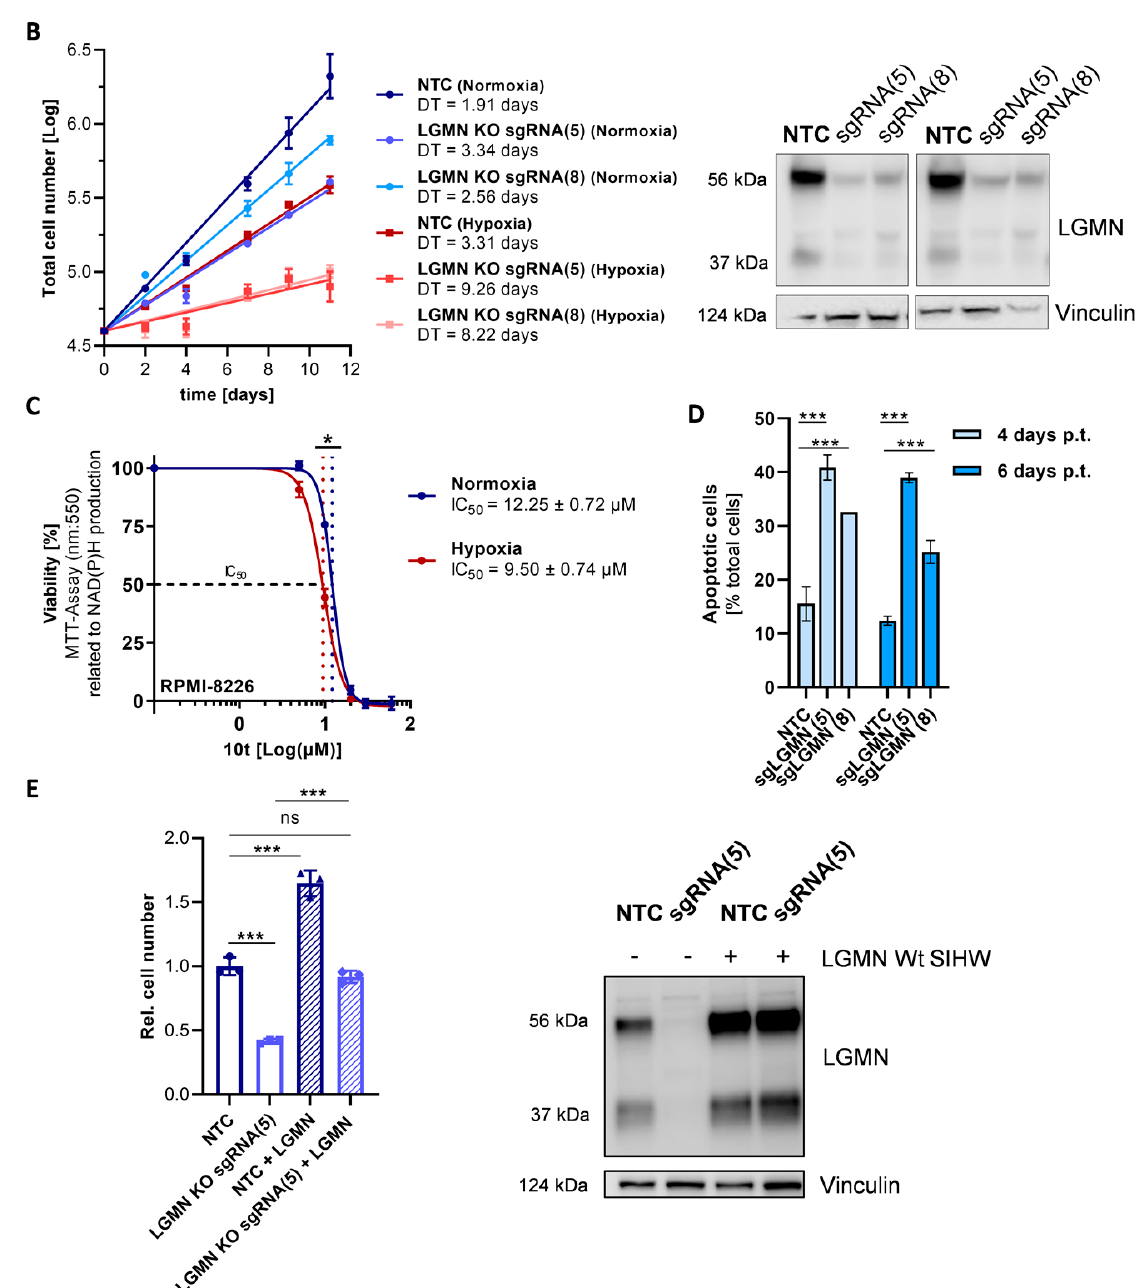
Figure 7. CRISPR/Cas9-based depletion of LGMN in MM cells confers enhanced growth disadvan- tage under chronic hypoxia: ( A ) Left: Competition growth assay of RPMI-8226 LGMN KO cells (sgRNA1, 3, 4 and 1 + 4) using NTC as a negative control and c-myc KO as a positive control in hypoxia (1% O 2 ). The percentage of GFP-positive cells measured via flow cytometry is normalized to NTC and day 0. Error bars indicate mean ± SEM of three technical replicates. Right: Representative Western blot of LGMN KO in RPMI-8226 cells used in the competition assay. Loading control: Nu- cleolin. ( B ) Left: Cumulative growth assay of RPMI-8226 LGMN KO (sgRNA5, 8) and NTC cells in normoxia (21% O 2 , blue colors) and hypoxia (1% O 2 , red colors). Error bars indicate mean ± SEM of three technical replicates. Right: Representative Western blot of LGMN KO in RPMI-8226 cells used in the cumulative growth assay. Loading control: Vinculin. ( C ) Viability assay in RPMI-8226 cells of 3 independent experiments after treatment with LGMN inhibitor 10t for 48 h under normoxia and hypoxia. Viability in [%] measured by NAD(P)H production. IC 50 is represented by black dashed